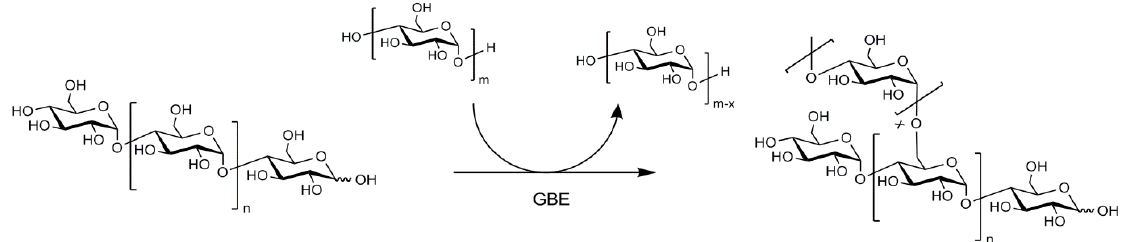
Figure 2. Action of the glycogen branching